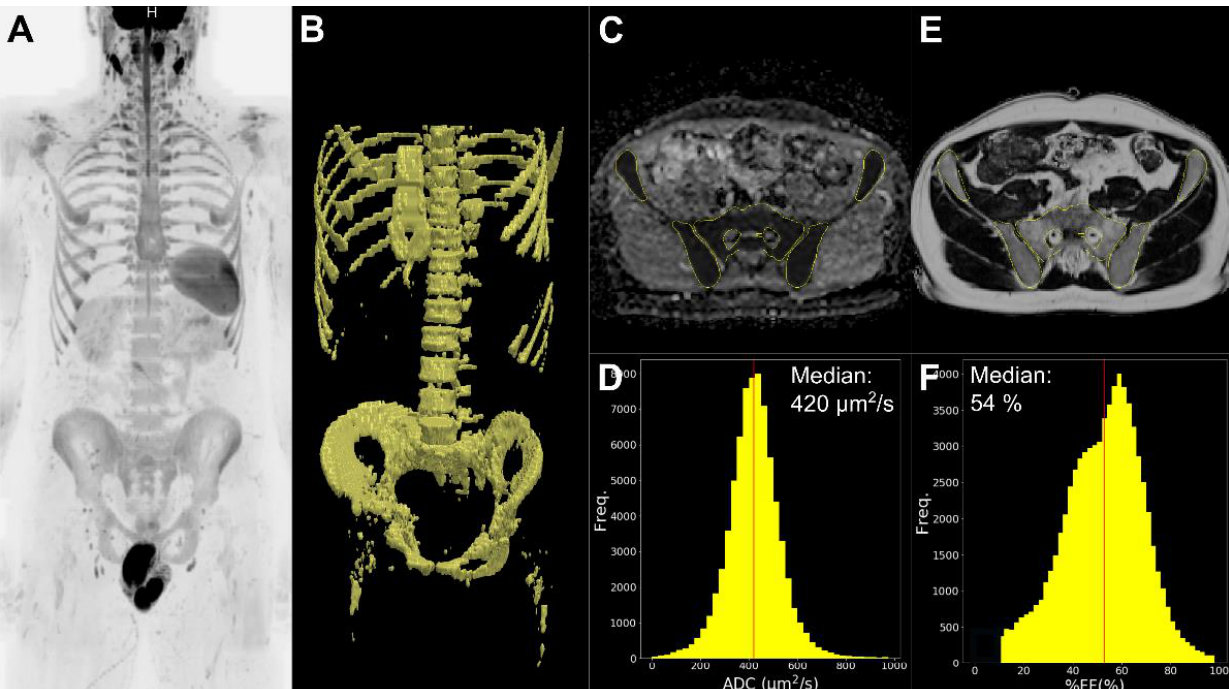
Figure 1. Illustration of the process for apparent diffusion coefficient (ADC) and relative fat fractions (%FF) extraction in a 30-year-old man who performed WB-MRI for early cancer detection. Based on the acquired diffusion-weighted image (b900) seen in coronal MIP with inverted grayscale ( A ), the bone marrow mask ( B ) was obtained using a semi-automated software that combines calculation of a simulated diffusion-weighted image, signal intensity thresholding, and manual editing. Only the three lower body stations were considered for the analysis because the head/neck coil array yielded different signal-to-noise levels for the head/neck station that would have necessitated a separate threshold value for semi-automated segmentation. The bone marrow mask was projected onto the ADC map computed from the diffusion-weighted image ( C ), the ADC distribution in bone marrow obtained (yellow histogram) and the median value (red line) calculated ( D ). The %FF map computed from the Dixon images was slice matched and resampled to the resolution of the diffusion-weighted images and the bone marrow mask projected onto the resampled fat fraction map ( E ) to extract the distribution of bone marrow %FF values and to calculate the median value (red line) ( F ). Voxels with %FF values below 15% or ADC above 1000 µm 2 /s were excluded from the masks to limit measure biases produced by soft tissues included in the bone marrow segmentation due to subject motion between sequence acquisitions.